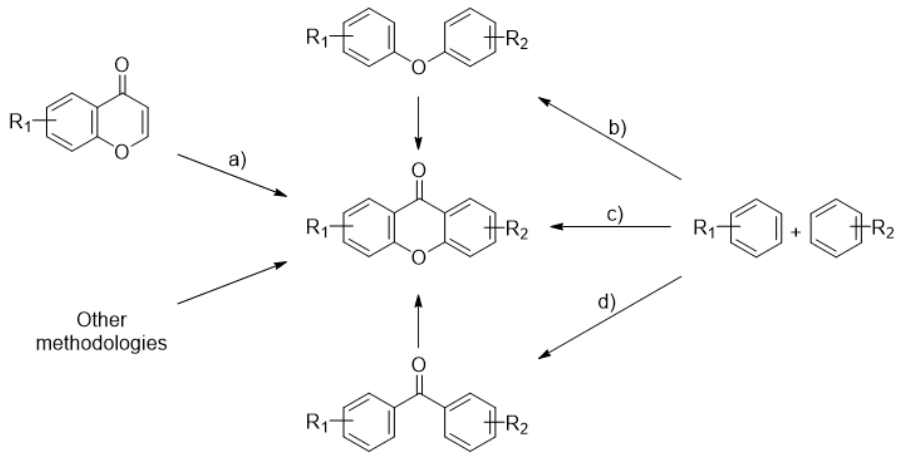
Figure 8. Commonly used synthetic routes of xanthones.